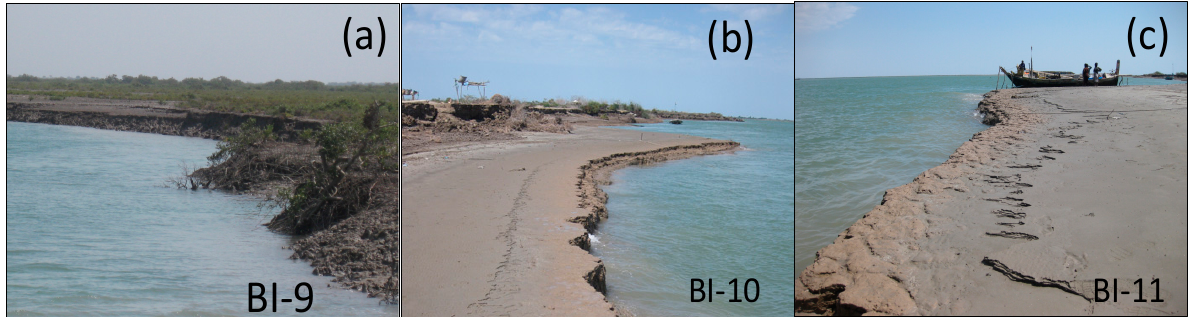
Figure 7. Land erosion and seawater intrusion into BIs along the Sindh coast. Seawater engulfing the islands’ banks is visible in ( a – c ).